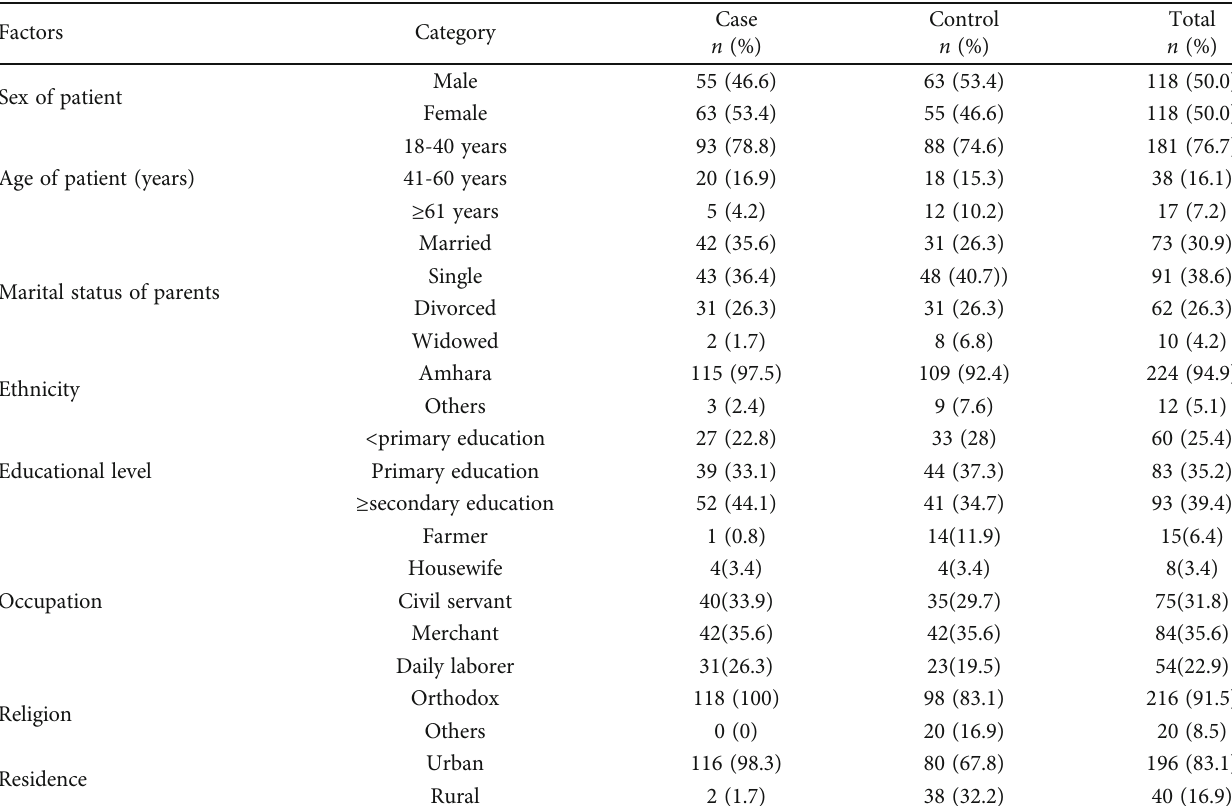
Ethiopia, 2020 ( n = 118 cases and 118